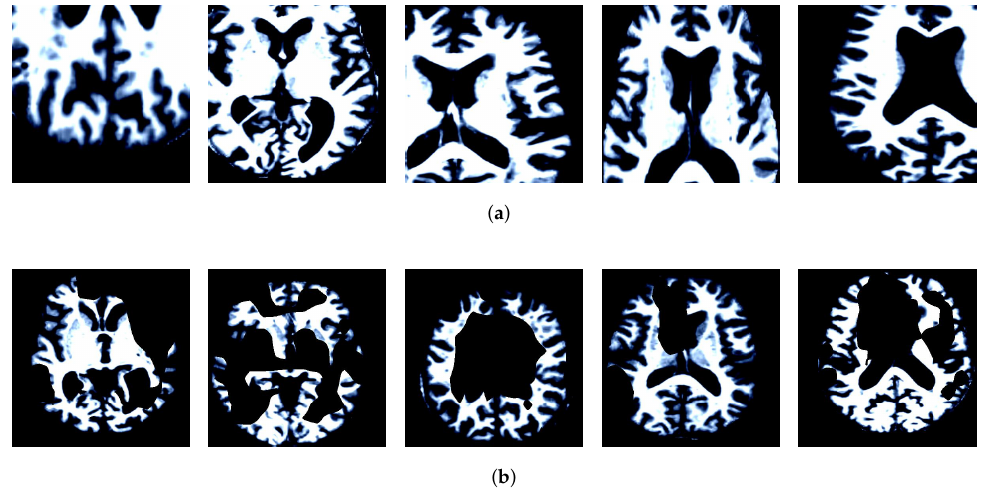
Figure 8. Visualization results of data augmentation ( a ) Attention Cropping. ( b ) Attention Dropping.